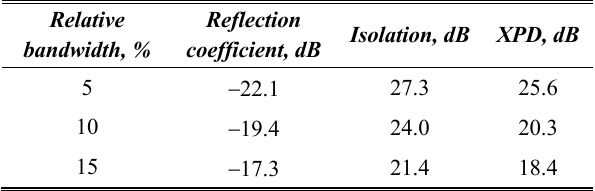
TABLE I. C HARACTERISTICS OF OPTIMIZED 2- STEP SEPTULUM POLARIZATION CONVERTERS FOR VARIOUS FREQUENCY BANDWIDTHS Relative Reflection Isolation, dB XPD, bandwidth, % coefficient, dB